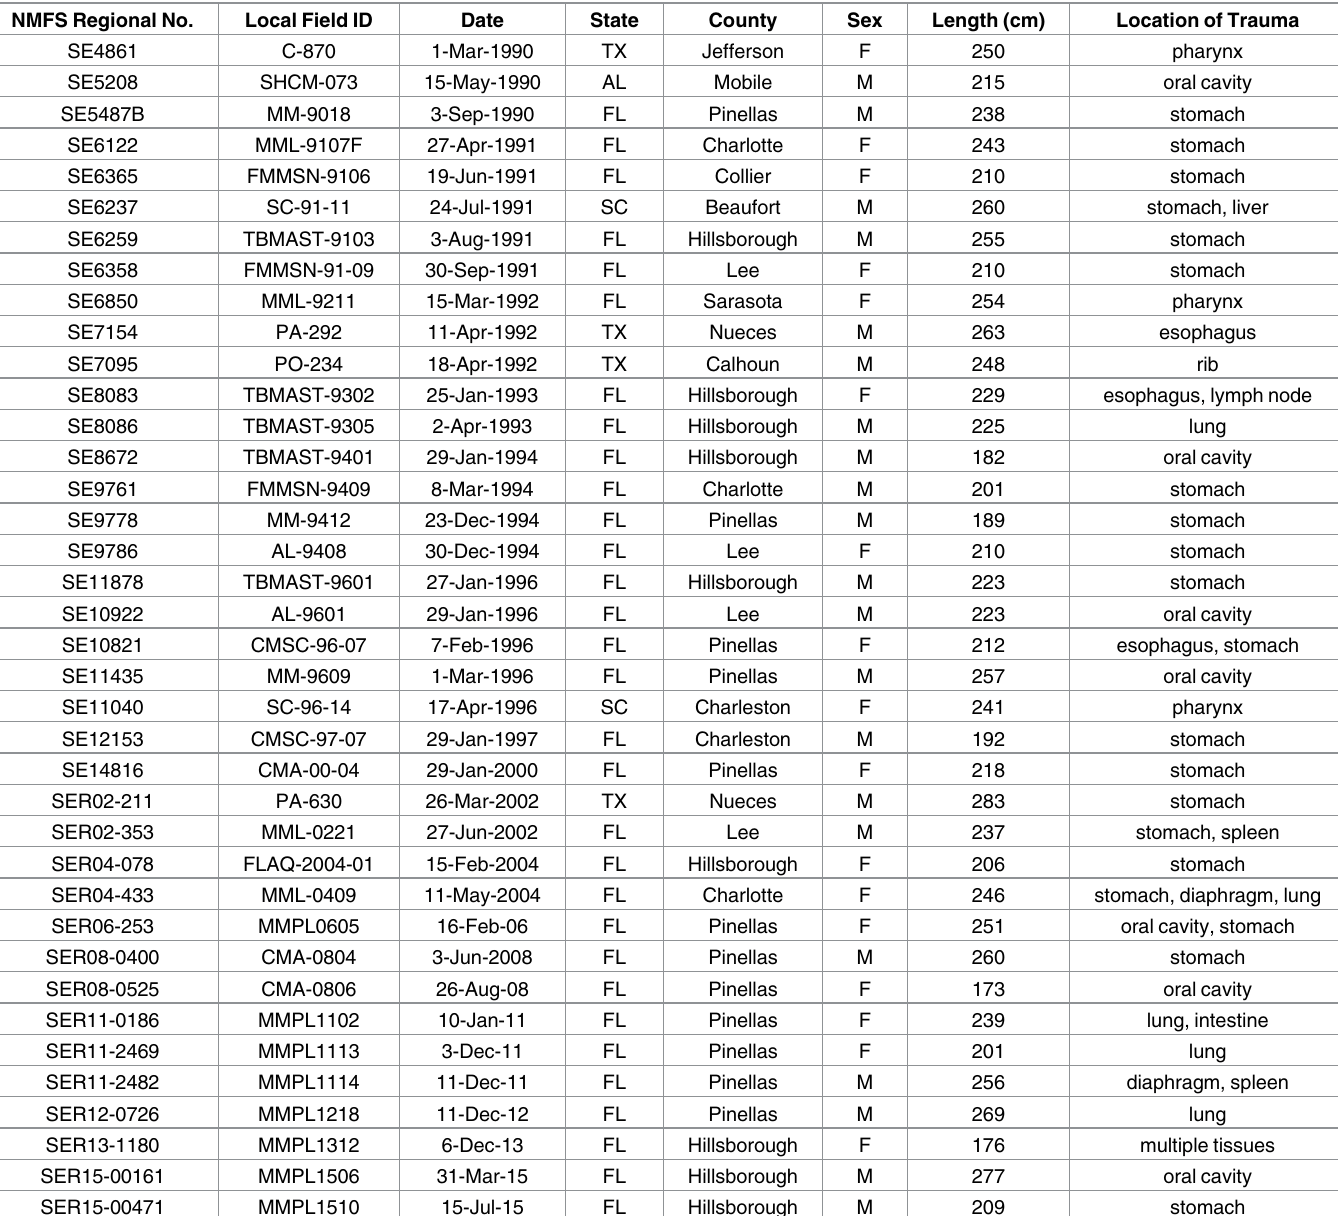
Table 3. Incidents of injuries attributed to catfish ingestion (n = 38) found in stranded bottlenose dolphins in the southeastern United States. NMFS Regional